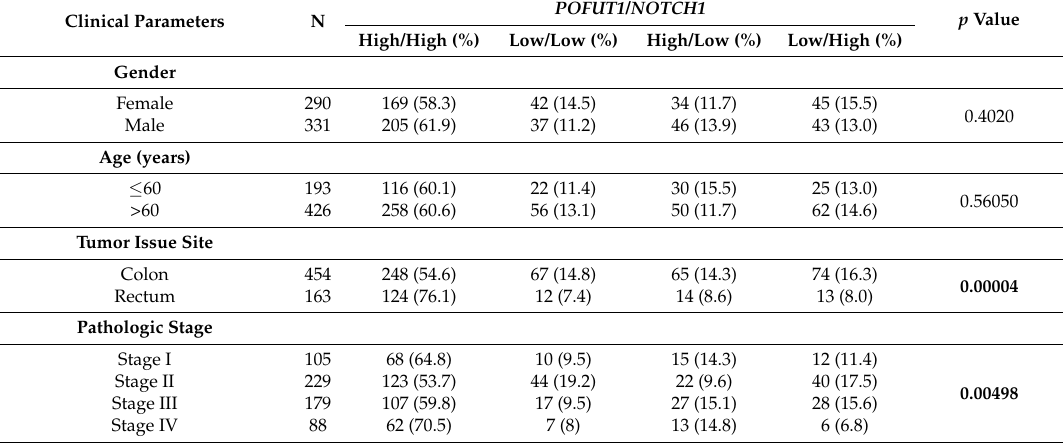
Table 3. Correlation between POFUT1/NOTCH1 expressions and clinical parameters in patients with